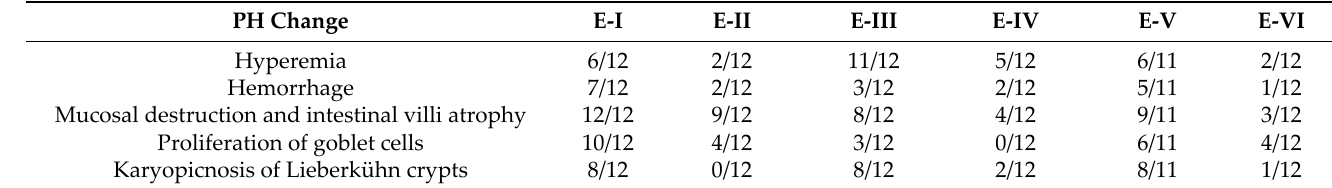
Table 7. The score of the PH changes of the duodenum of broilers submitted to AFB1 and T‑2 toxin combination in relation to the numbers of animals examined.